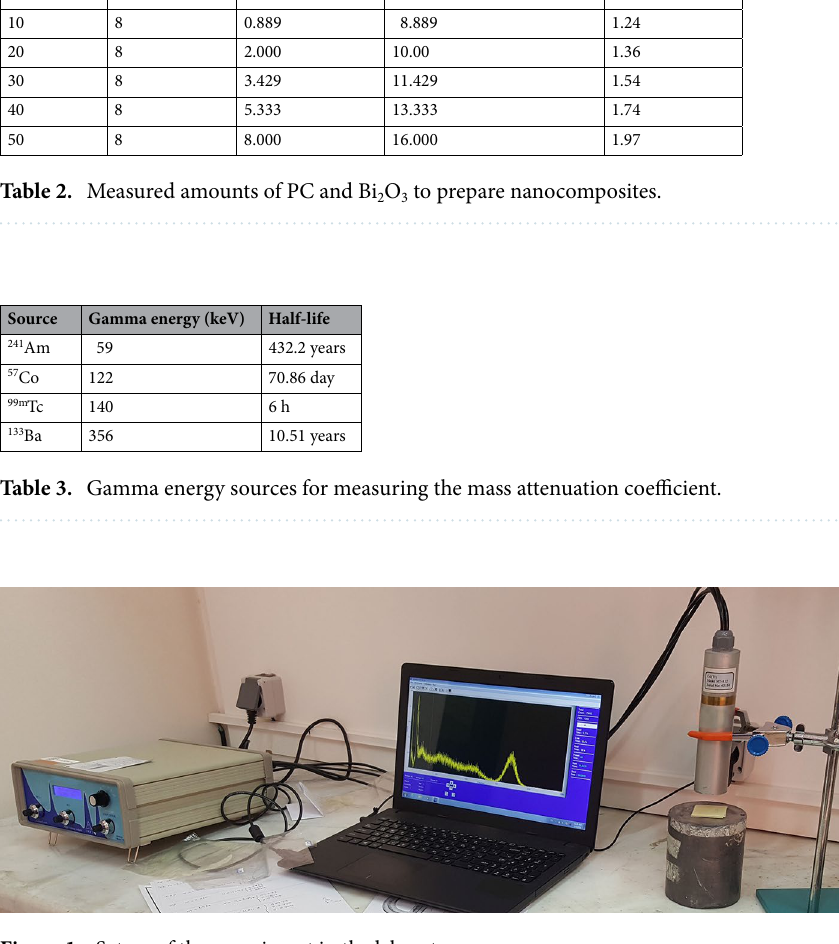
Figure 1. Set up of the experiment in the